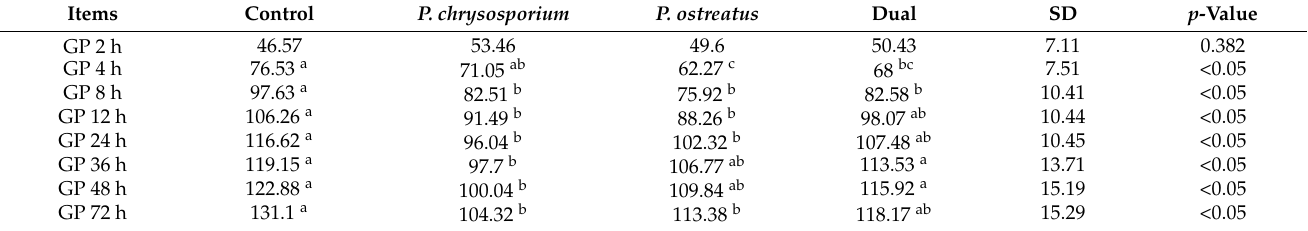
Table 3. In vitro gas production from white tea residue after incubation with different fungi cultures.